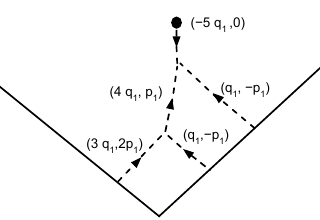
Figure 15 . An example of a multi-junction con(cid:12)guration for the four-pole background of (3.10) with p 2 = 2 p 1 and q 2 = 3 q 1